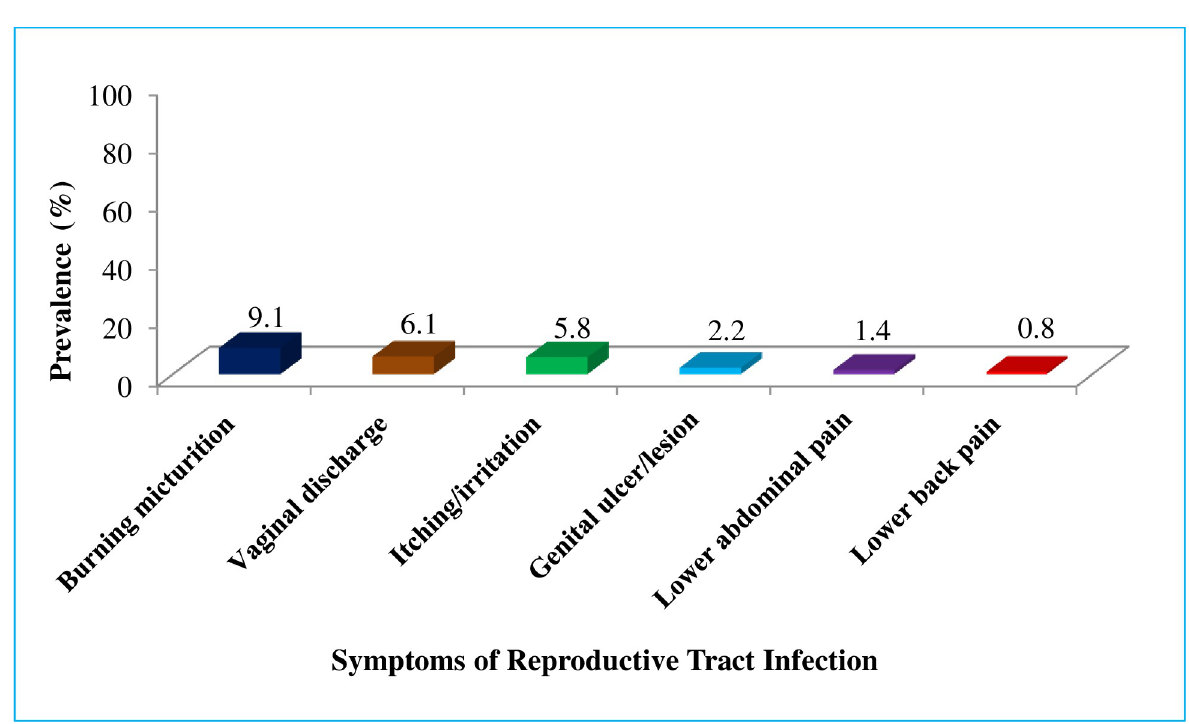
Fig 1. Self-reported symptom-based prevalence of RTI among reproductive-age women in Dessie City, northeastern Ethiopia, January to March 2019.